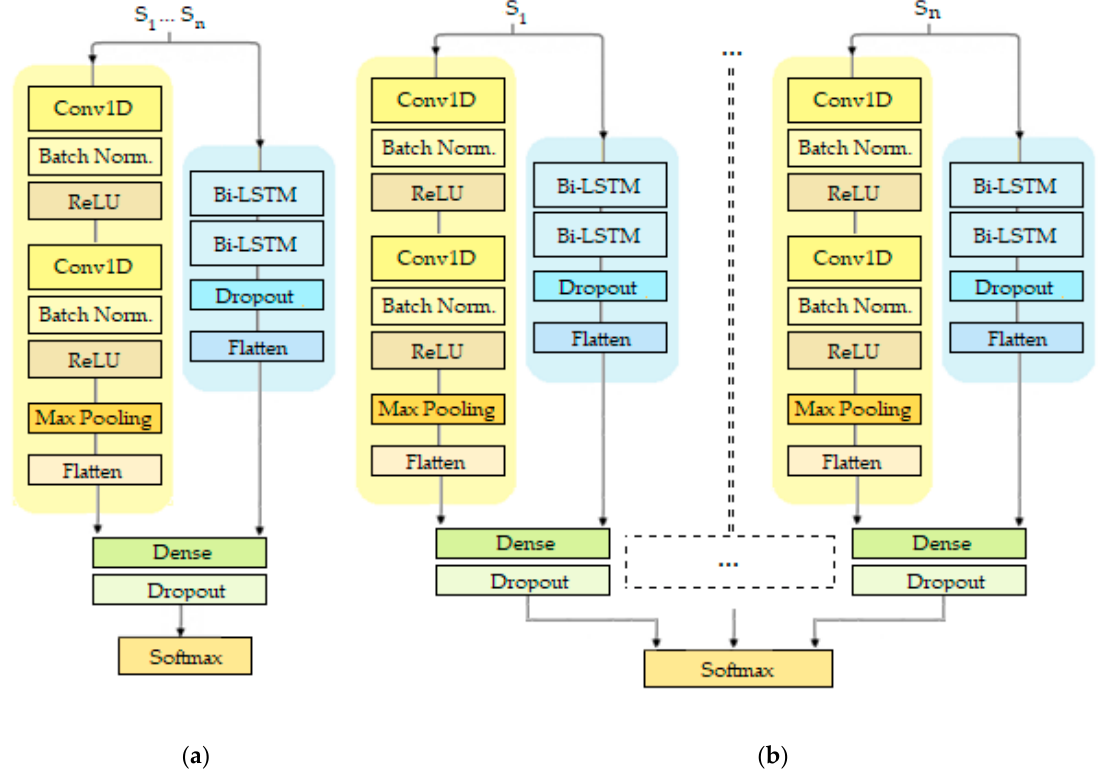
Figure 5. Deep neural networks (DNNs) which implement different information fusion methods. ( a ) Data-level; ( b ) decision-level.